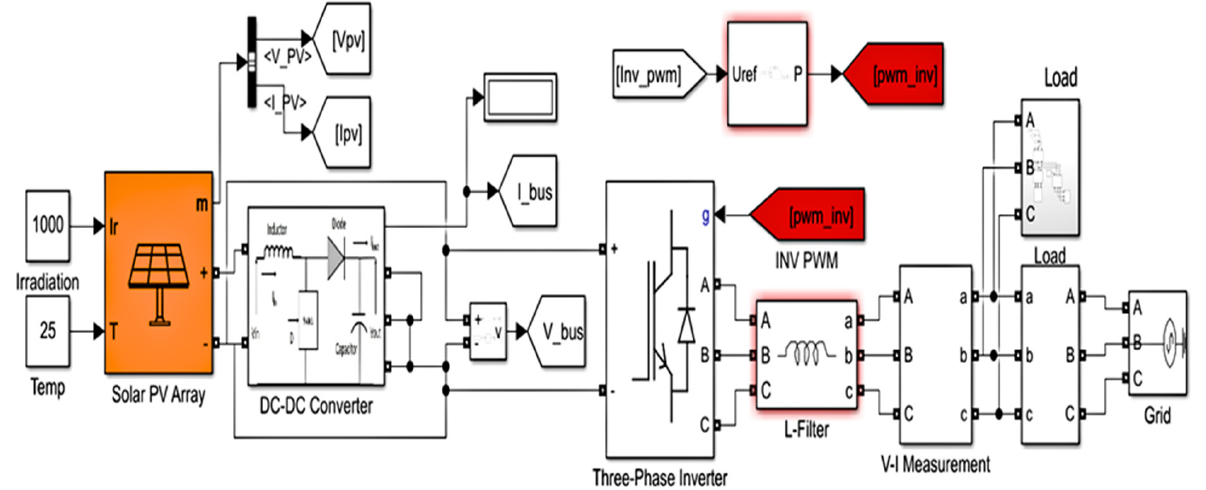
Figure 8. MATLAB Simulink Model of the solar photovoltaic system. Table 2. Solar PV module configuration.